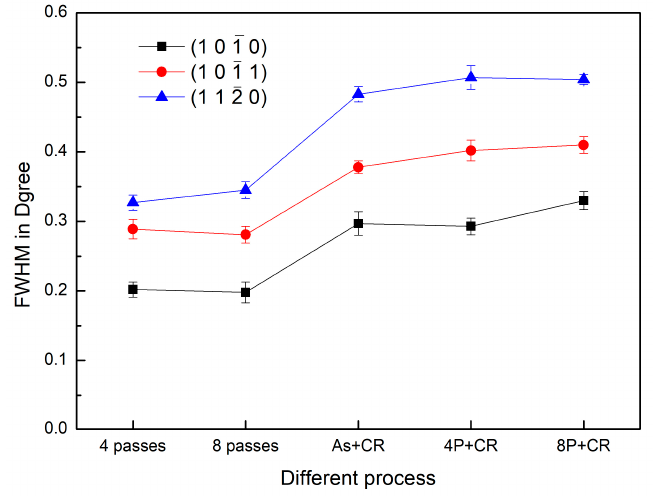
Figure 11. FWHM (full width at half maximum) for three characteristic peak of CP-Ti at different processing stage.